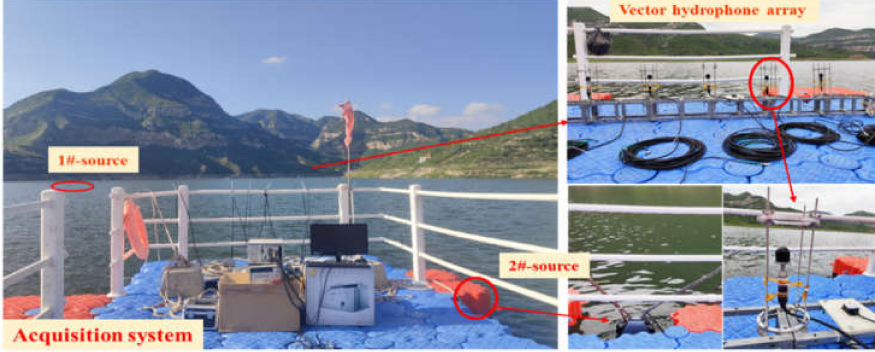
Figure 8. The field test map and hydrophone array distribution map.